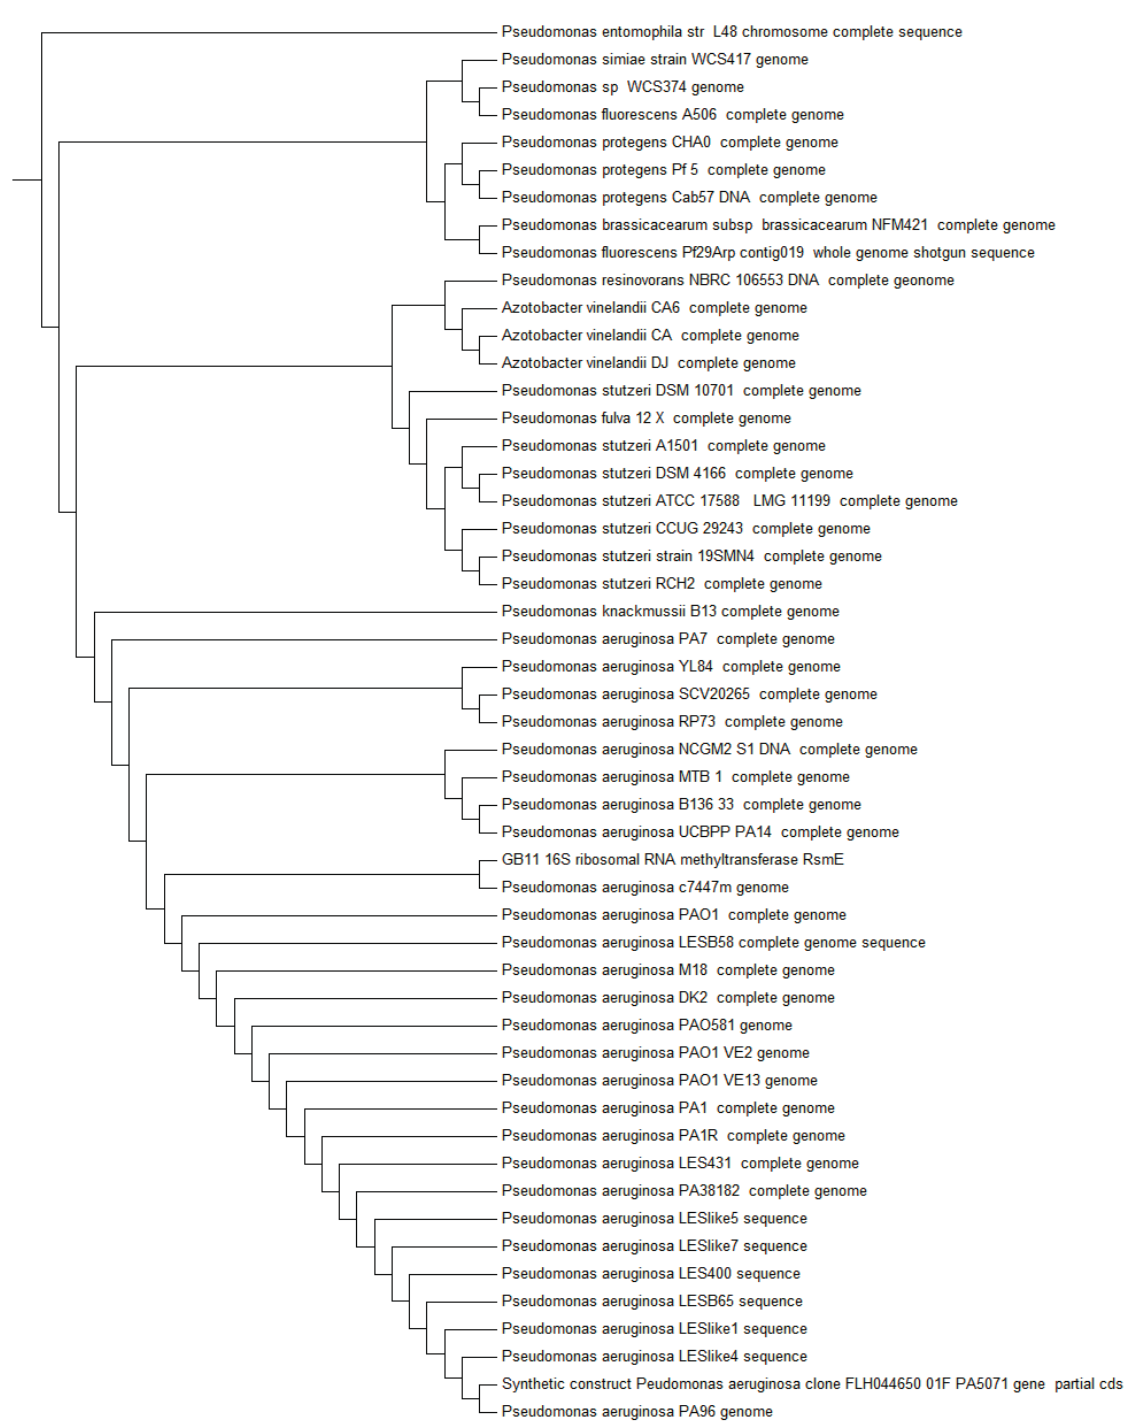
Figure 4. Bacterial identification of strain GB11 using 16S rRNA gene phylogenetics analysis. Phylogeny tree shows the 16S rRNA gene of strain GB11 clustered closely with P. aeruginosa strains. All sequences data are obtained from NCBI